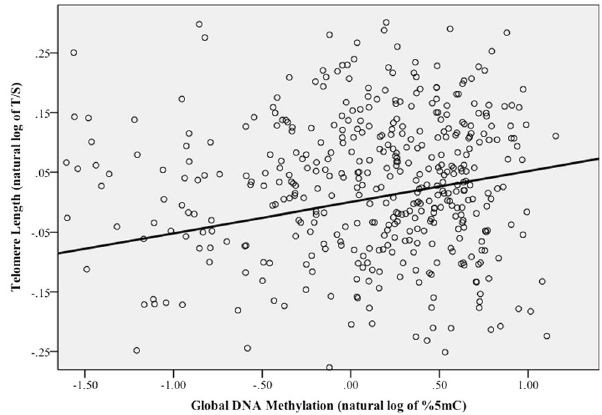
Figure 1. Partial regression plot of the model between Global DNA Methylation (natural log of %5 mC) and Telomere Length (natural log of T/S) for the overall population.